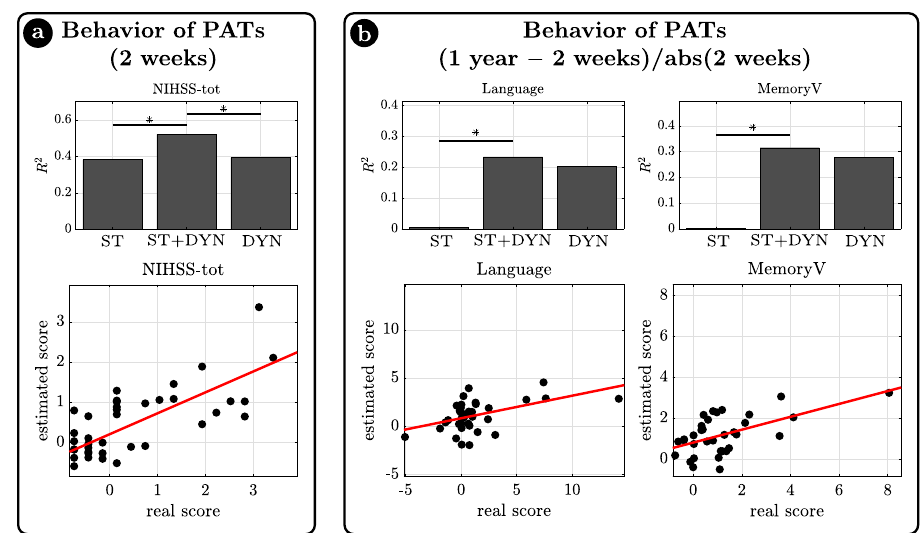
Fig. 7 | Relationship between Dynamic measures and behavior. The ratio like- lihood test was used to test whether the addition of dynamic information to the staticmeasureswouldsigni fi cantlyincreasetheabilityofageneralizedlinearmodel to describe behavioral de fi cits (in terms of explained variance). Static measures were represented by static principal component (ST) values, while dynamic infor- mation was represented by dynamic principal components. a At fi rst behavioral scores of sub-acute patients were considered. When dynamical PCs were used as dynamic regressors, only the global measure of behavioral impairment (NIHSS-